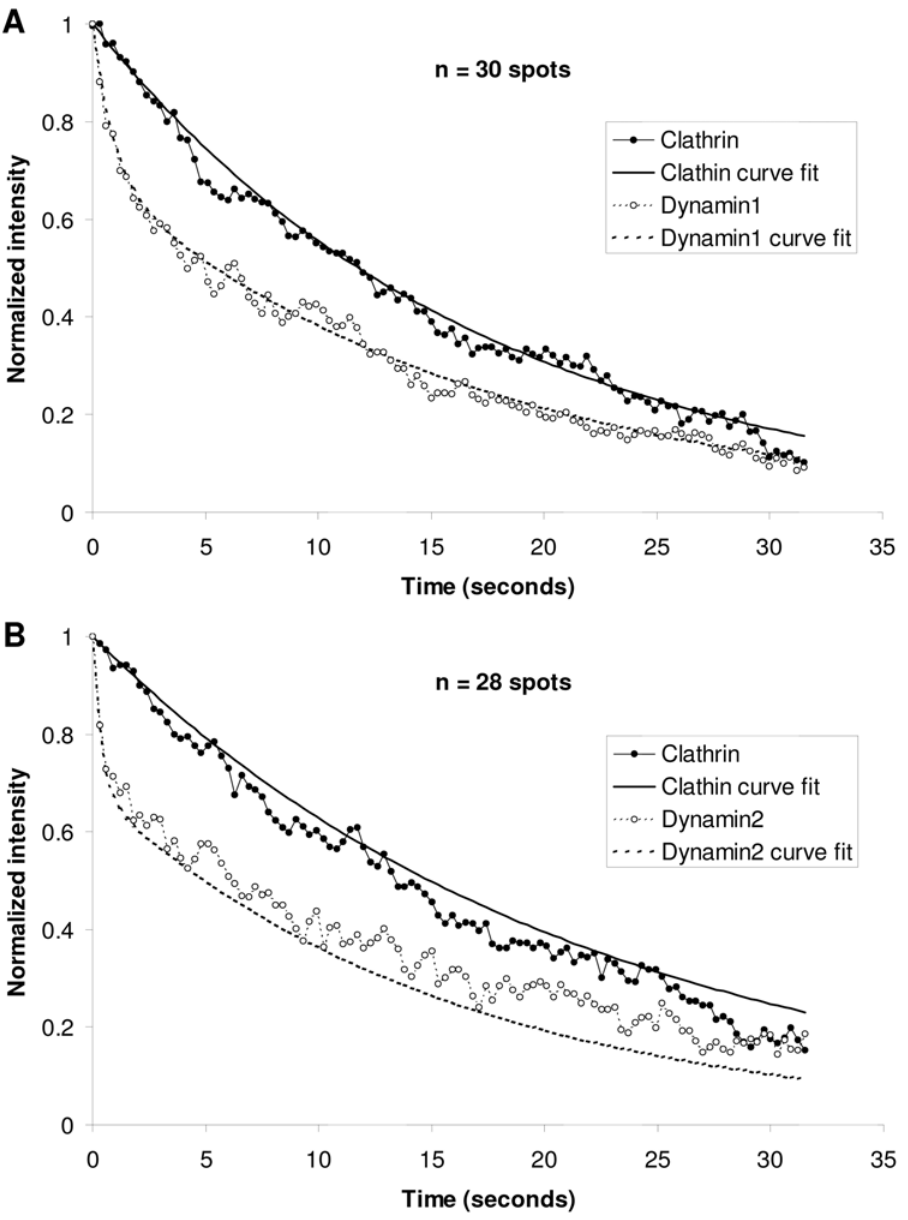
Figure 5. Different phases of dynamin intensity decrease at sites of clathrin-mediated endocytosis in PC12 cells. PC12 cells co- transfected with clathrin-dsRed and dynamin1-EGFP (A) or dynamin2-EGFP (B) were imaged by live-cell TIR-FM. Decreases in dynamin fluorescence were aligned so that the peak was set to time 0, and clathrin and Dynamin fluorescence at time 0 were normalized to 1. (B and C) demonstrate the decreases in clathrin and dynamin1 or dynamin2, at the sites of 30 or 28 disappearing clathrin spots, respectively. In each case, the decrease in clathrin intensity fits a single exponential, while both dynamin1 and dynamin2 fit double exponentials (all r 2 values . 0.98).